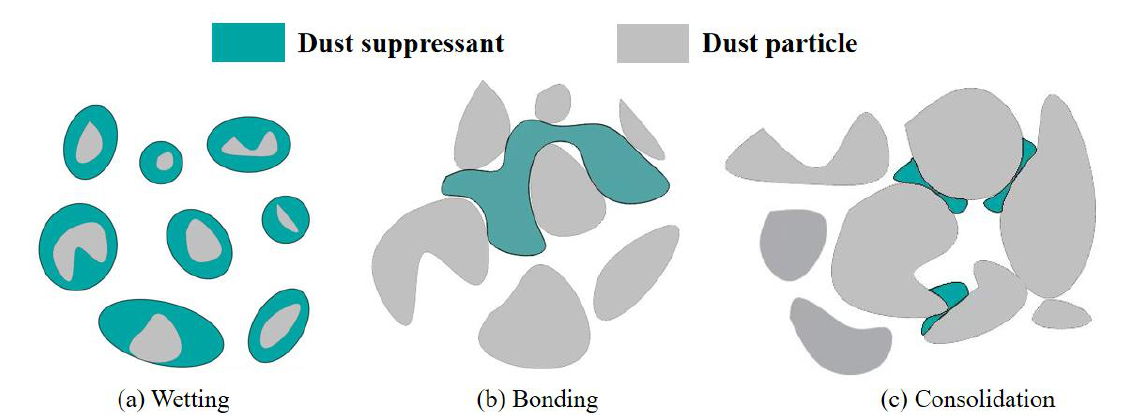
Figure 3. Dust suppression mechanism.